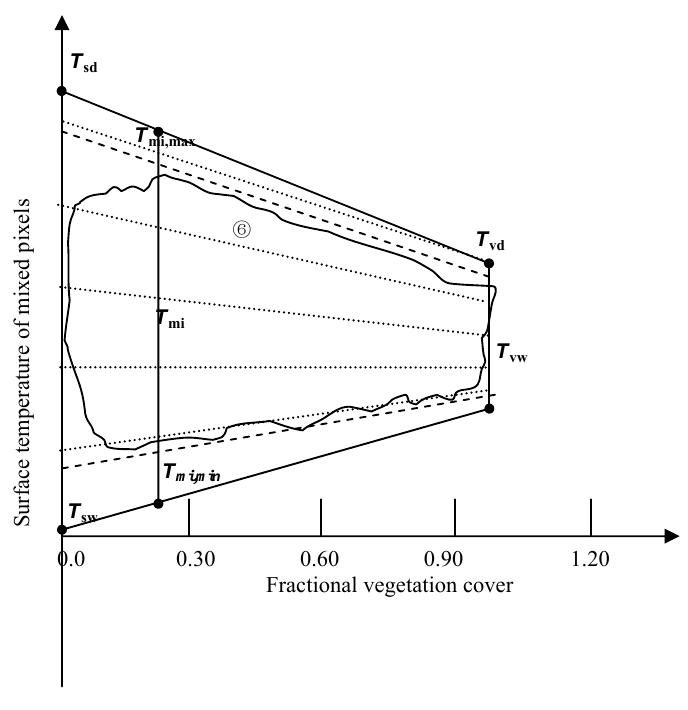
Figure 1. Scatter plot of surface temperature against vegetation fraction cover (cid:31) true dry edge (cid:31) observed dry edge (cid:31) observed wet edge (cid:31) true wet edge (cid:31)iso-line of equal vegetation fraction cover (cid:31) iso-line of equal soil water